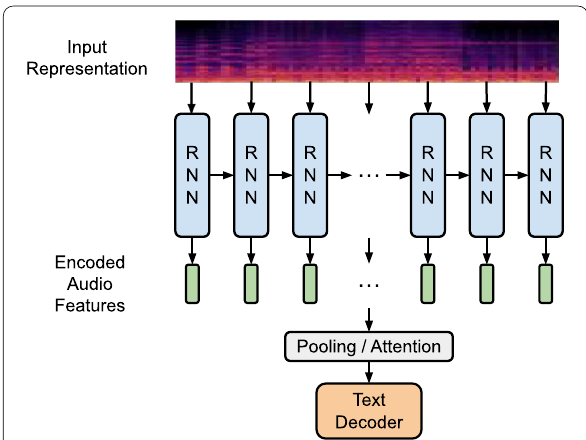
Fig. 2 Diagram of an RNN audio encoder for acoustic encoding. The RNN encoder aims at modeling temporal relationships within the input representation. The encoded audio features usually have the same number of time frames as the input representation and interact with the decoder through a pooling or attention mechanism